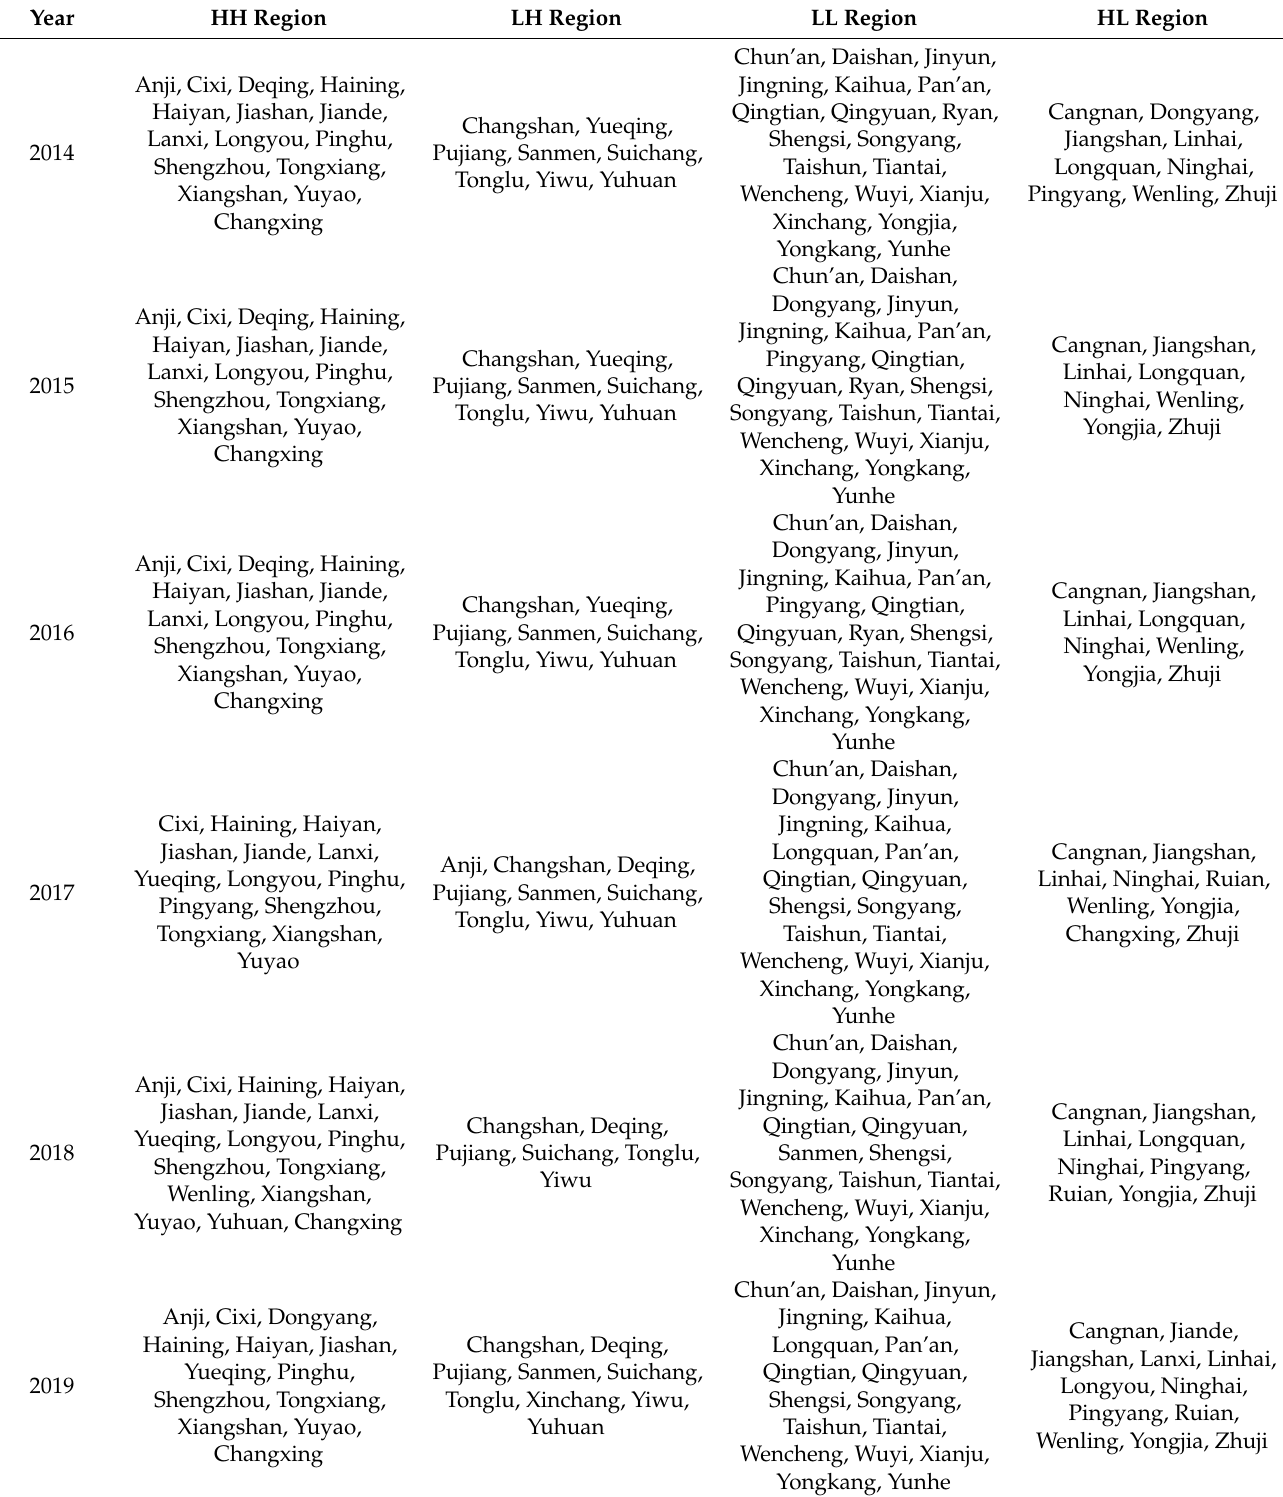
Table 6. Regional distribution of Moran’s I during